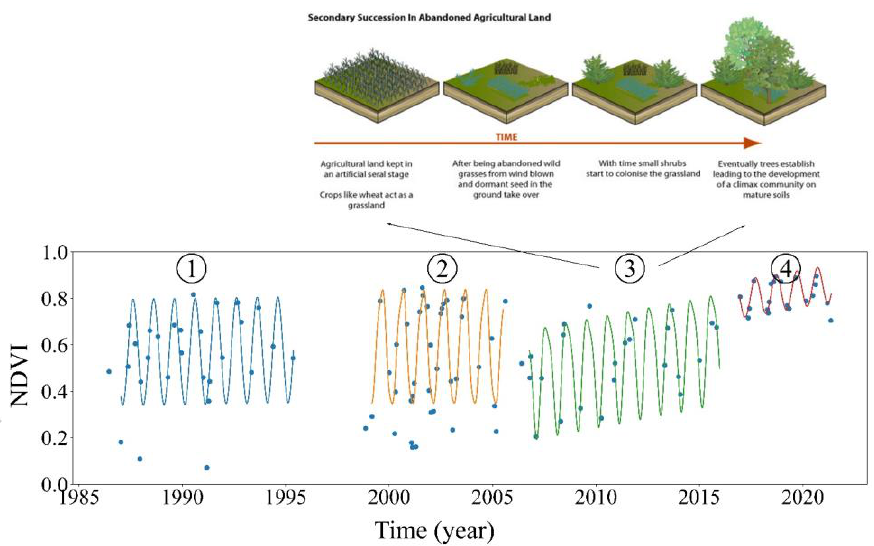
Figure 4. Blue dots are NDVI values of Landsat observations. Fitted segments, which are derived from Landsat time series and CCDC temporal segmentation algorithm, represent different stages of croplands. The stages are marked by numbers in circles. The first and second stages are in active use, the third is in post-abandonment secondary succession, while the fourth is in stable woodland stage. Vegetation succession in abandoned croplands is reflected in the third segment.